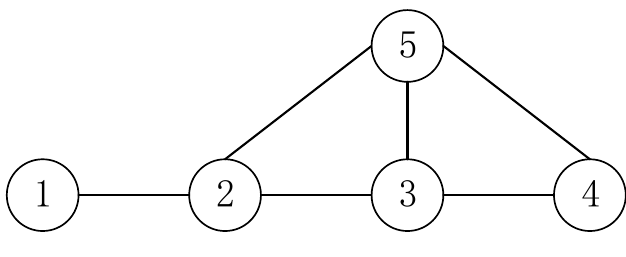
Figure 1. The communication topology graph of five